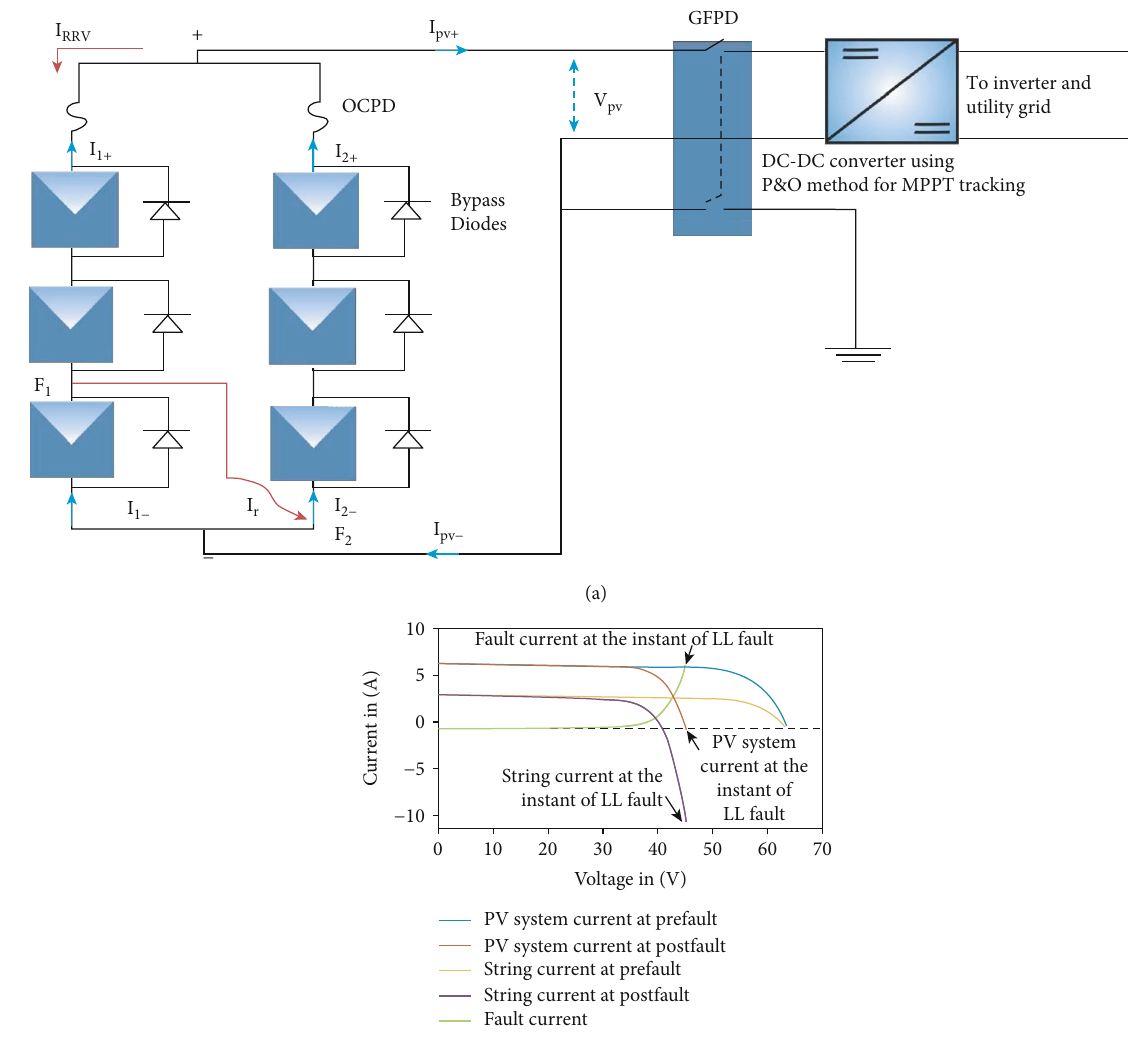
Figure 9: (a) SPV system without blocking diodes in the event of a fault. (b) I-V without blocking diodes [82].